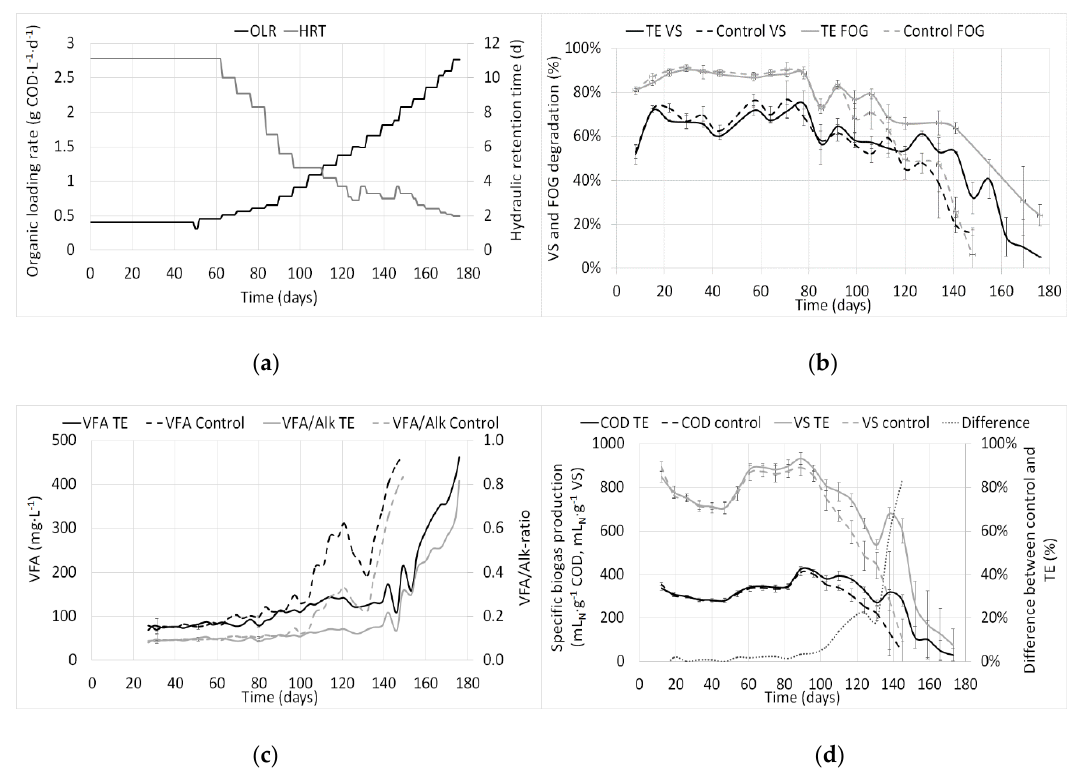
Figure 4. ( a ) Organic loading rate and hydraulic retention times in control and TE (trace element)- supplemented reactors [28]; ( b ) vs. and FOG degradation efficiency in control and TE-supplemented reactors [28]; ( c ) VFA and VFA/Alkalinity ratio in control and TE-supplemented reactors [28] and; ( d ) biogas production from control and TE-supplemented reactors as both functions of vs. and COD. Error bars represent one standard deviation from the